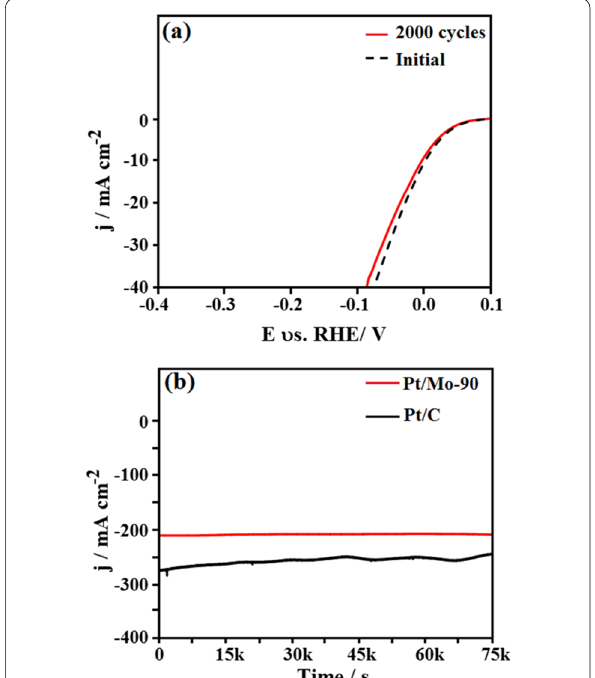
Fig. 7 a LSV curves of Pt/Mo-90 composite prior to and posterior to 2000 CV cycles; b The chronoamperometric response of Pt/Mo-90 and Pt/C under 0.25 V −